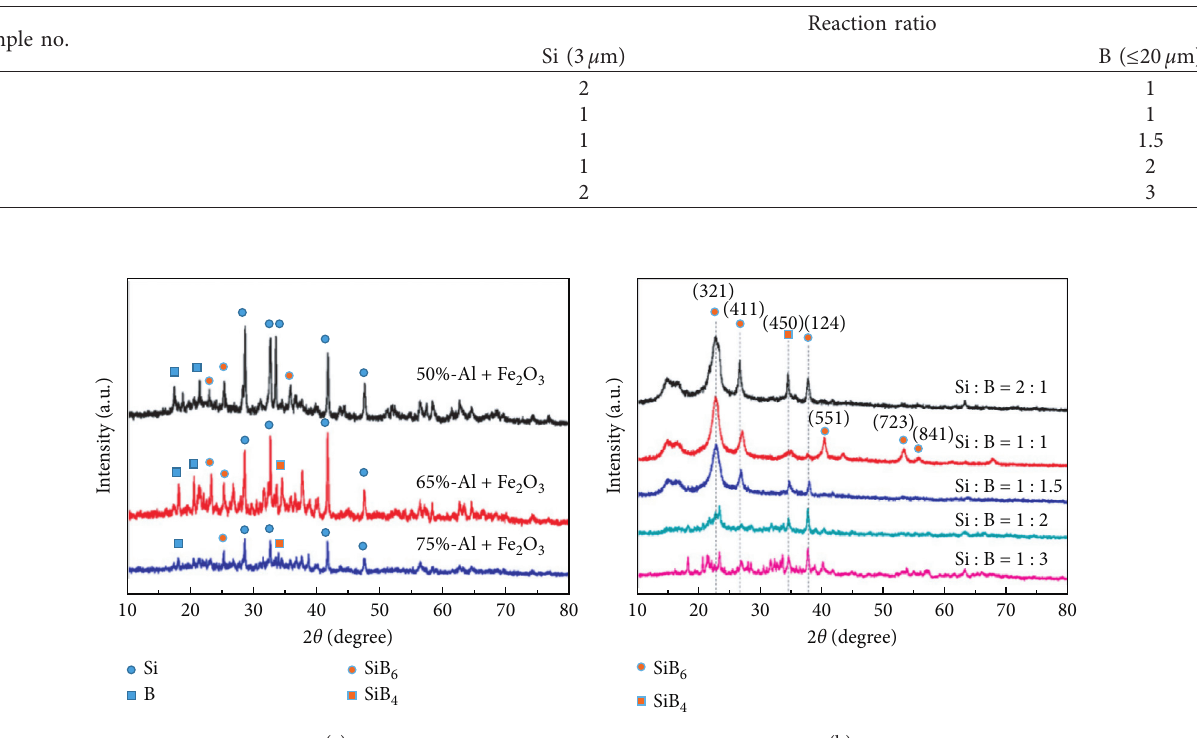
Figure 2: XRD spectrum of all samples (a) with different thermite ratios and (b) different molar ratios of Si/B.